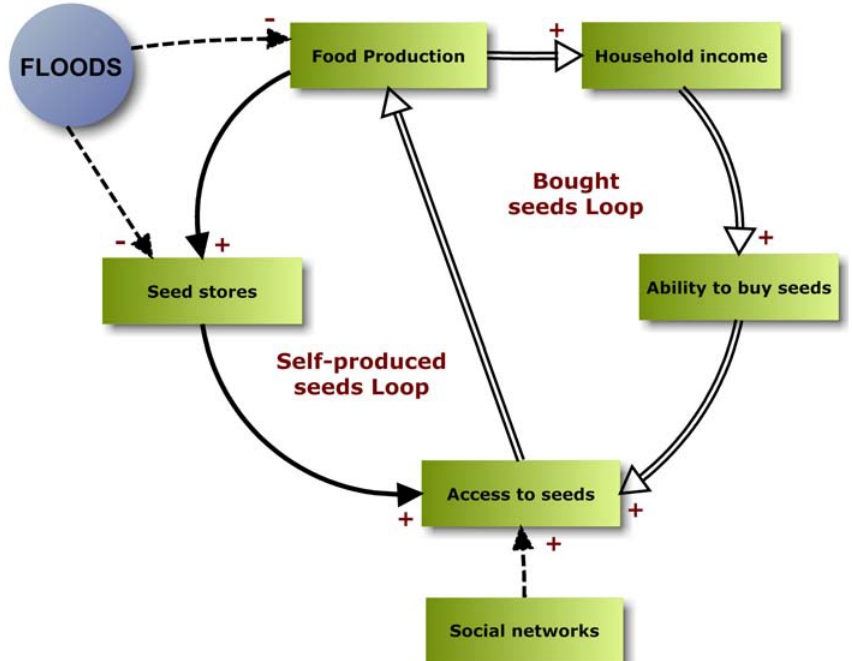
Figure 4. Causal loop diagram of the impact of floods on farmers access to